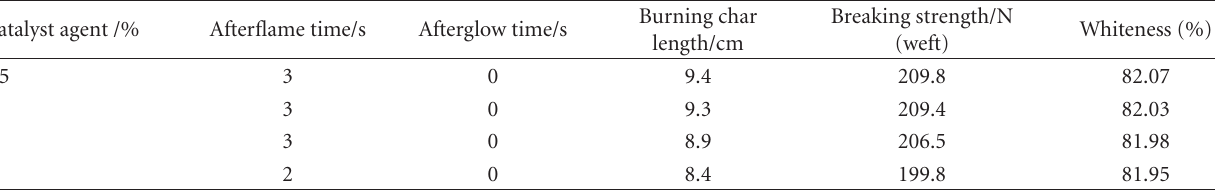
Table 4: E ff ect of the catalyst agent concentration on the fire-retardant performance. Catalyst agent /% Afterflame